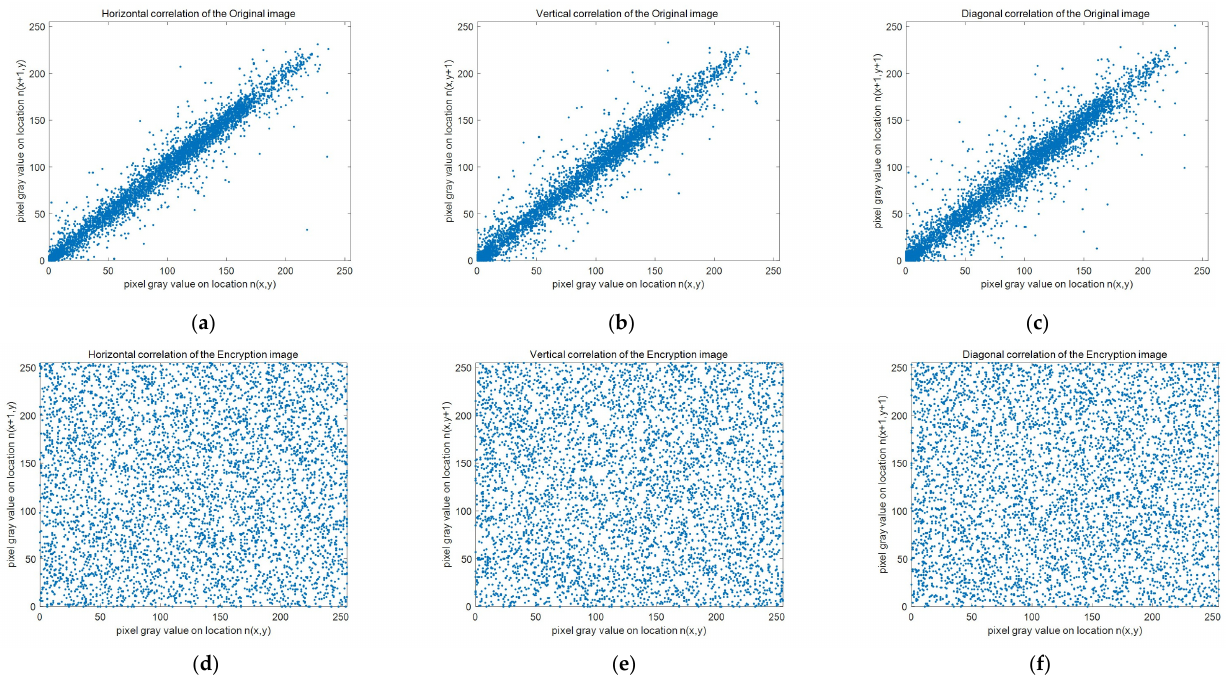
Figure 15. Adjacent pixel correlation of image 5.2.08: ( a – c ) original image; ( d – f ) encrypted image.